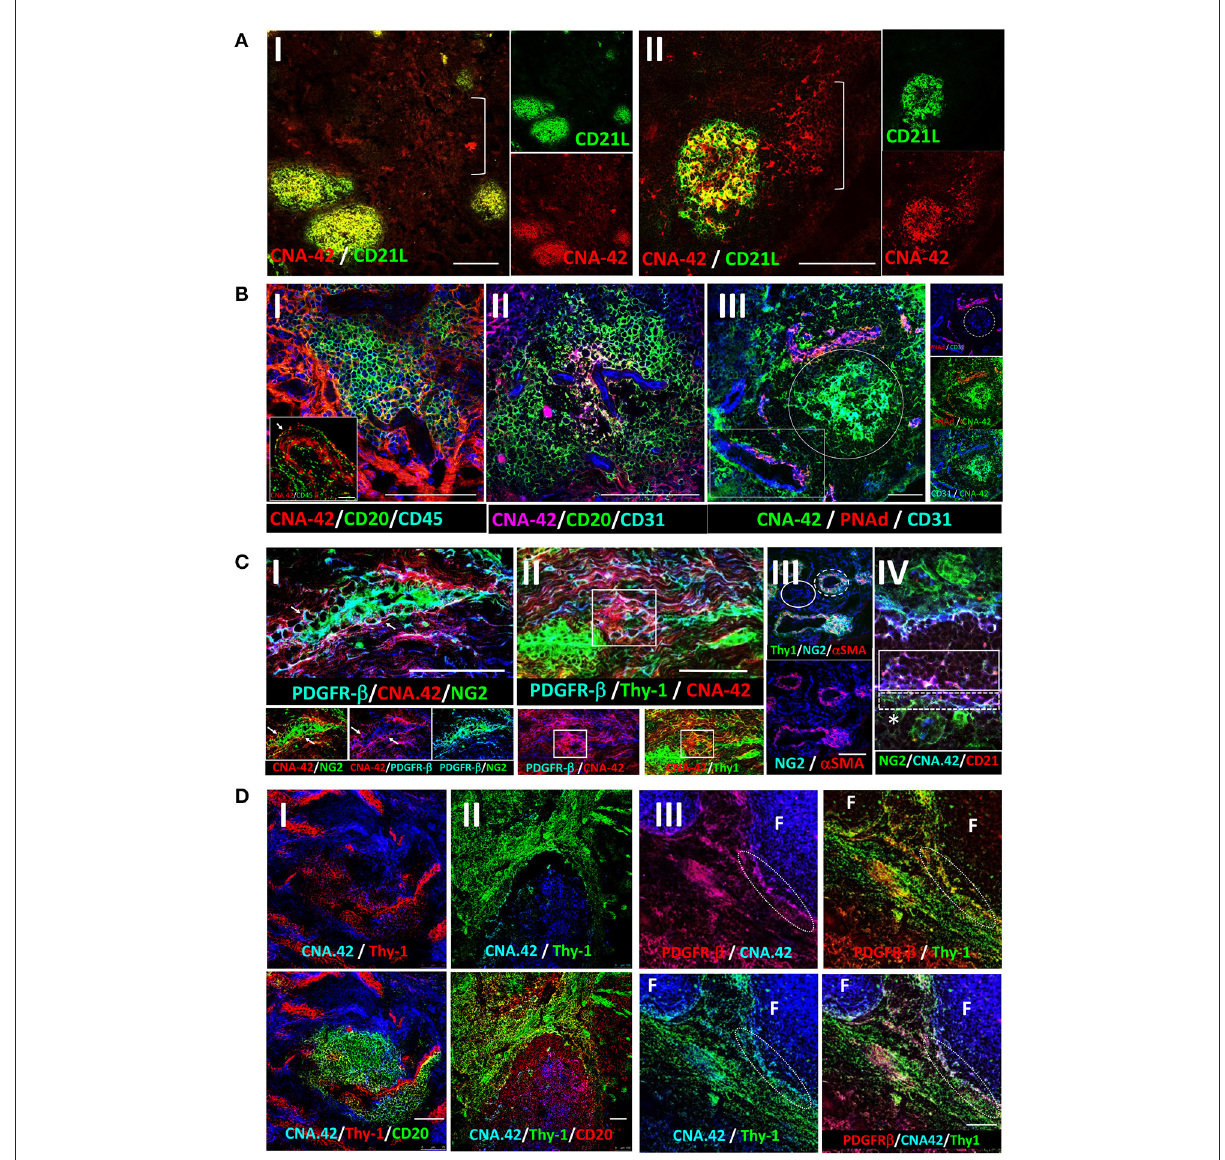
FIGURE1 Immunohistochemical localization of human synovial and tonsillar FDCs in the perivascular space vs. established follicles. (A) CNA.42 distribution in the tonsil (A-I) and RA synovium (A-II) . Labeling of human FDCs with the mAb CNA.42 (red) colocalizes with an Ab specific for the FDC-restricted CD21 long isoform (CD21L, green) in FDC reticula. The white bracket borders extra-reticular FDCs that are CNA.42 + /CD21L − . (B) RA synovial CNA.42 + cells (red) are: (B-I) associated with CD20 + B cells (green) and do not colocalize with CD45 (blue). The inset in the lower left corner shows the synovial intima with CNA.42 + fibroblasts (red/white arrow) arranged side by side with CD45 + intimal macrophages (green) in the lining layer. (B-II) directly related to the CD31 + BVs (blue) within CD20 + B cell follicles (green), and (B-III) directly located in juxtaposition with the CD31 + (blue)/PNAd + (red) HEVs (white rectangle). The white circle borders established CNA.42 + FDC reticulum (green) detached/distant from the vascular walls. (C) Early FDC markers in the RA synovial perivascular space: (C-I) Synovial labeling with the FDC marker CNA.42 together with the pericyte markers NG2, α SMA, and PDGFR- β shows that CNA.42 is expressed by cells immediately adjacent to the pericyte layer of the BVs (white arrows). (C-II) The CNA.42 + /PDGFR- β + early FDCs also express the fibroblasts marker Thy-1 (white rectangle) which is similarly expressed on the BV-associated type-1 pericytes (dashed while circle) but not on the dissociated type-2 pericytes (complete white circle) (C-III) . (C-IV) Pericyte-derived differentiating FDCs progressively acquire CNA.42 and CD21/CR2 expression. NG2 + pericytes (green) are marked by a star (*); and differentiating NG2 + (green)/CNA.42 + (blue) and CNA.42 + (blue)/CD21 + (red) FDCs are indicated by dashed and complete white boxes, respectively. (D) Co-labeling of the FDC marker CNA.42 and the fibroblast marker Thy-1 in established follicles (mature FDCs) of RA synovial ELS (D-I) and tonsils (D-II) . The fibroblast marker is significantly lost in mature FDCs populating established CD20 + B cell follicles. (D-III) Co-localization of CNA.42 (Blue), Thy-1 (green), and PDGFR- β (red) in the follicular (F) and inter-follicular areas. The dotted oval demarcates the loss of PDGFR- β and Thy-1 expression at the follicular border. Single channel, dual and triple overlays are shown in the different panels. Scale bare = 100